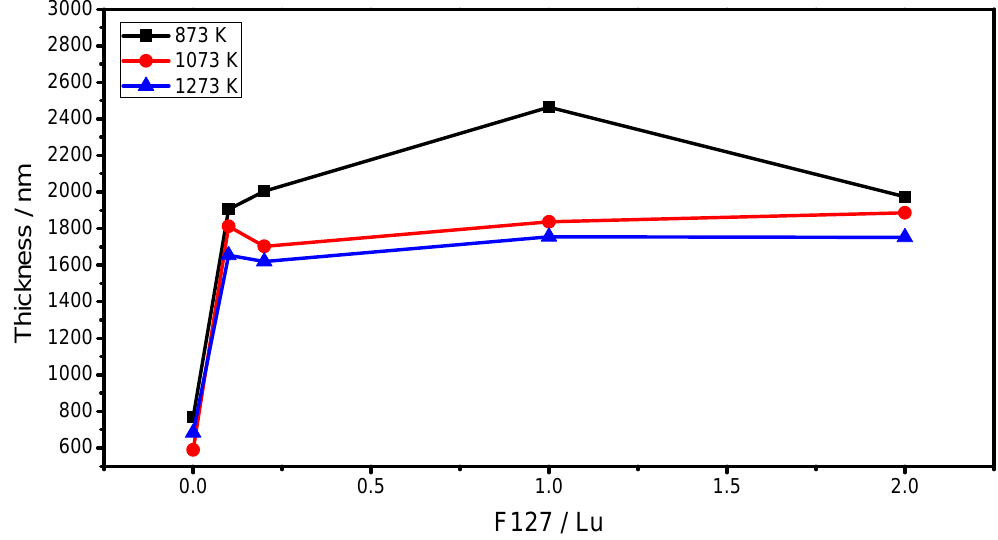
O :Eu 3+ F127 modified thin films 2 3